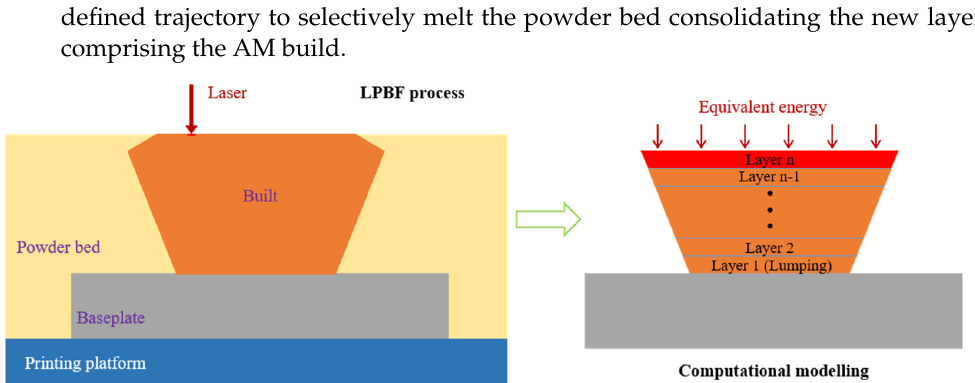
Figure 8. The schematic of the used layer-by-layer model for LPBF.